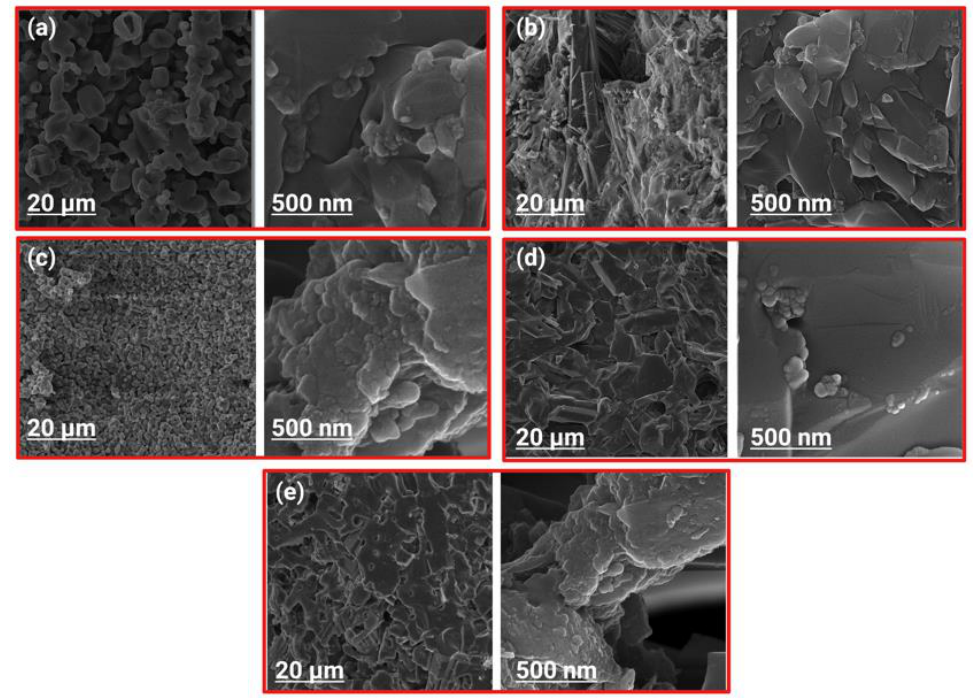
Figure 4. FE-SEM micrograph showing fracture surface of: ( a ) HA. ( b ) HA-0.5Li. ( c ) HA-1Li. ( d ) HA-2Li. ( e ) HA-4Li sample sintered at 1250 °C.